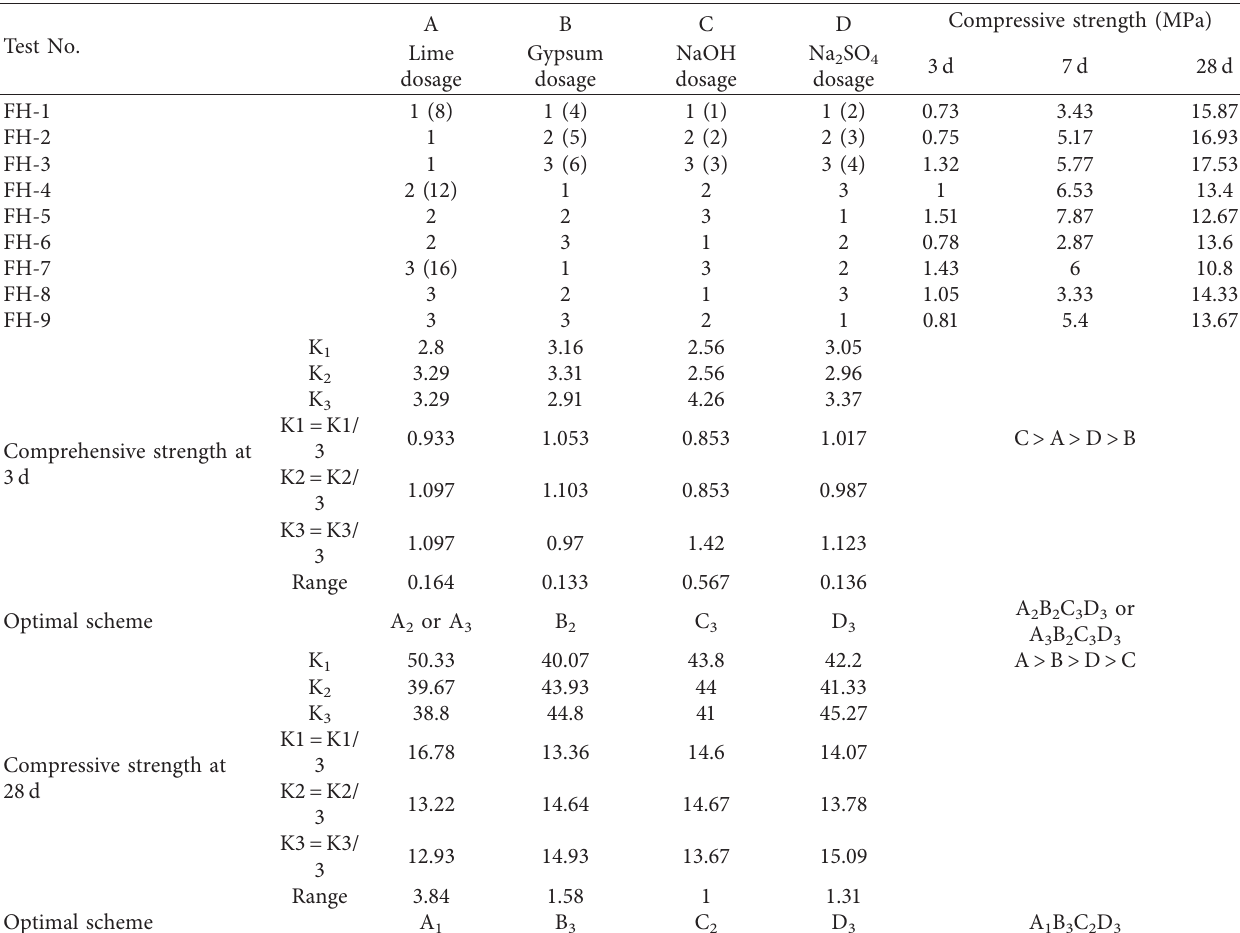
Table 7: Analysis results of orthogonal test for compressive strength of slurry.